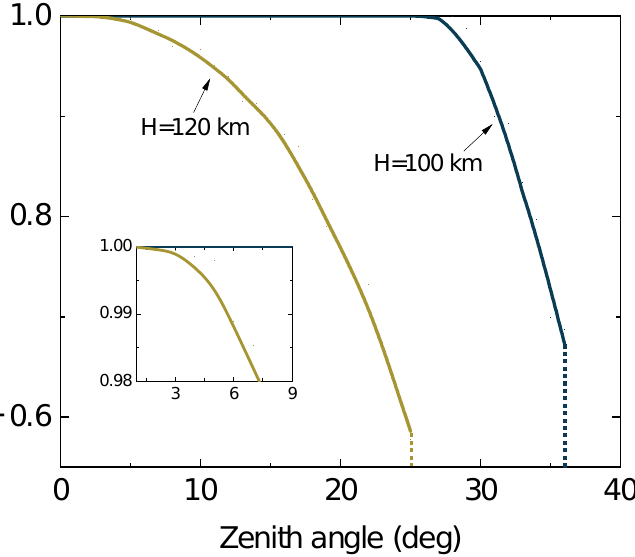
Figure 6. The optimal attenuation coefficient as a function of zenith angle for the satellite altitudes H = 100 km (blue line) and H = 120 km (yellow